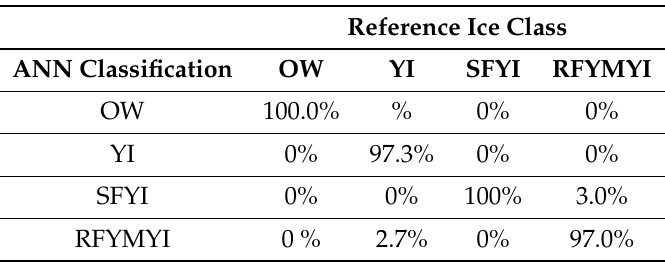
Table 6. Classification results compared to reference data samples from each class, averaged over different neural network topologies, TS-X acquisition 19 April